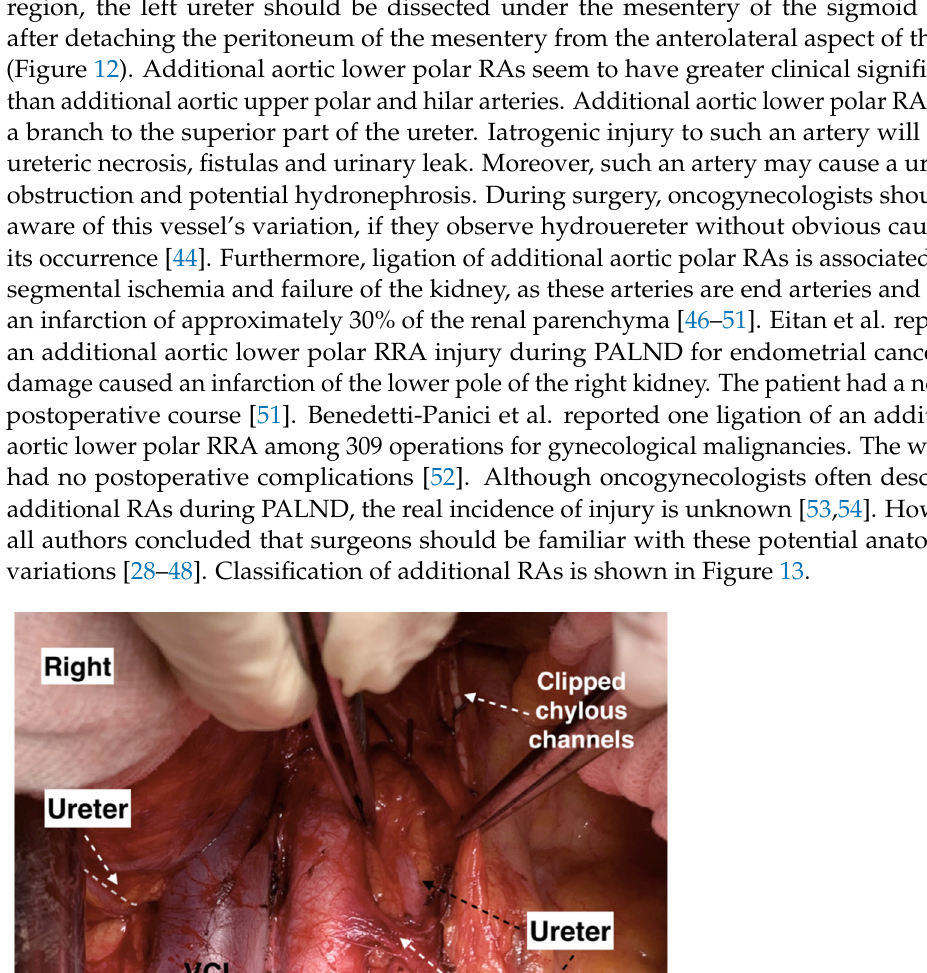
Figure 13. Additional renal arteries classification. Type I—additional renal arteries arising from the main renal artery. IA—additional upper polar renal artery, IB—additional lower polar renal artery. Type II—additional renal arteries arising from the abdominal aorta or renal vein, IIA— additional aortic upper polar renal artery, IIB—additional aortic lower polar renal artery, IIC— additional aortic upper hilar renal artery, IID—additional aortic lower hilar renal artery, IIE— additional lower polar renal artery arising from the left renal artery and entering the right kidney. The artery has a preaortic and precaval course. Type III—first and second additional renal arteries. Only polar arteries are shown, but the arteries may enter the hilar or polar part of the kidney. IIIA—first additional arteries arising from the abdominal aorta, IIIB—second additional renal ar-